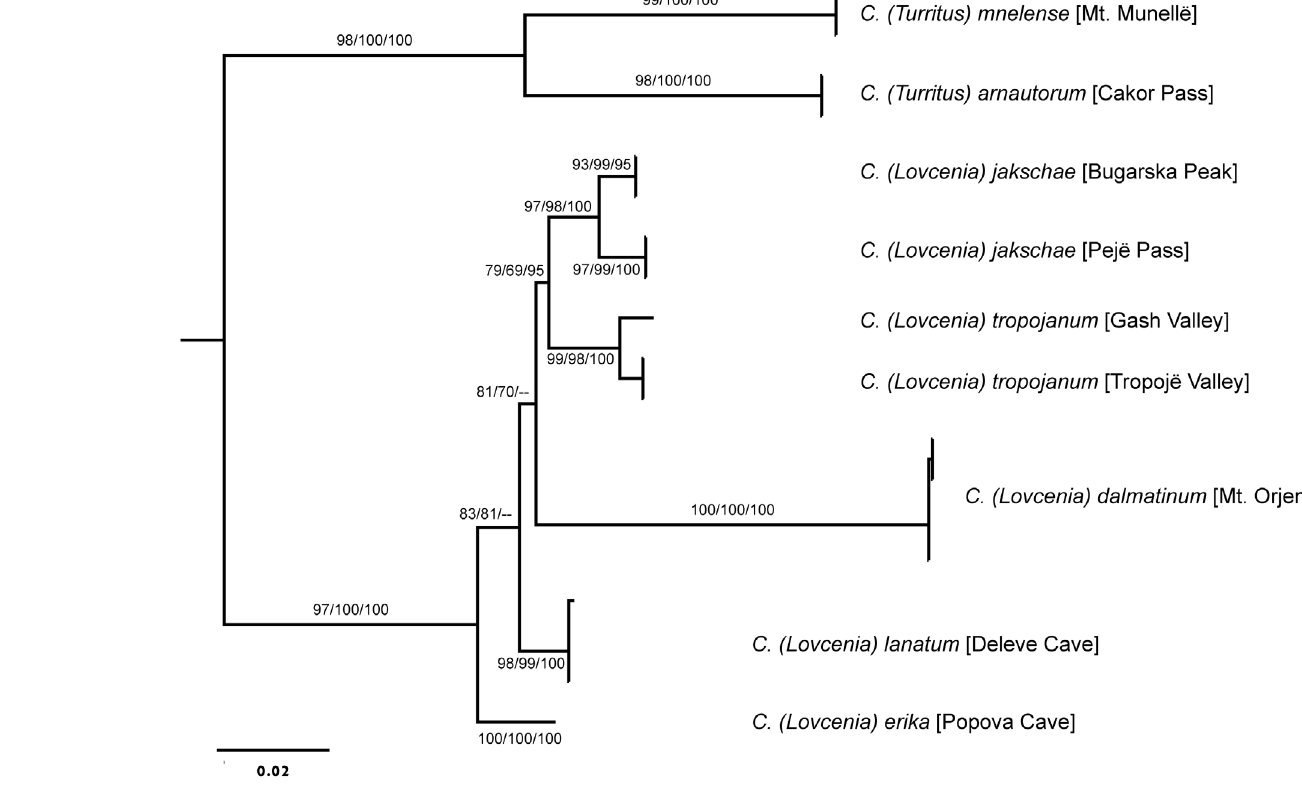
Fig. 4. Maximum Likelihood consensus tree of Cochlostoma ( Lovcenia ) Zallot et al. , 2015 inferred from COI , 16S rRNA and nuclear histone H3 genes. Branch support values are: SH-aLRT support / ML ultrafast bootstrap support / Bayesian posterior probability percentage estimates. Note that two species of C. (Turritus) Westerlund, 1883 were used to define the root of the C. (Lovcenia)